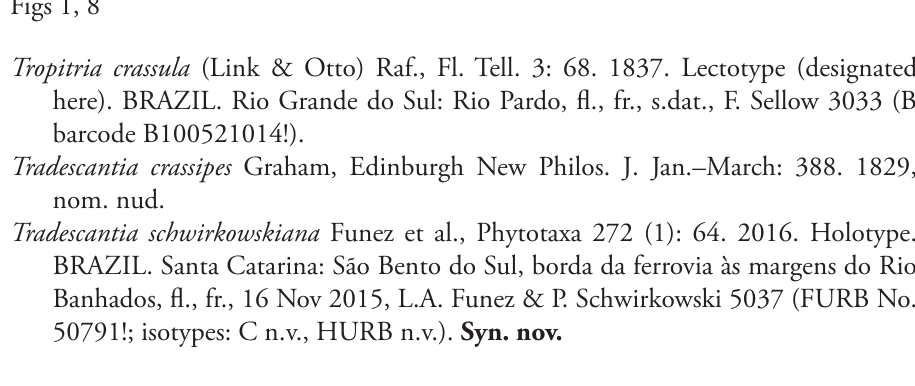
Tropitria crassula (Link & Otto) Raf., Fl. Tell. 3: 68. 1837. Lectotype (designated here). BRAZIL. Rio Grande do Sul: Rio Pardo, fl., fr., s.dat., F. Sellow 3033 (B barcode